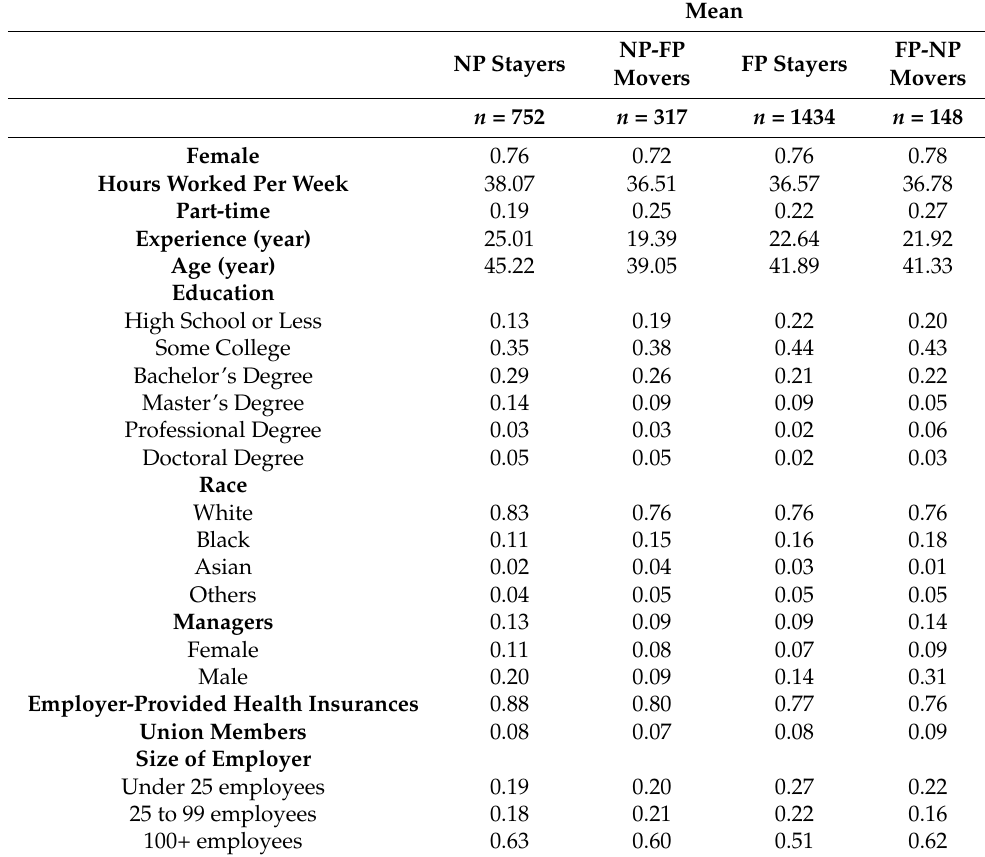
Table 3. Baseline worker characteristics of the four